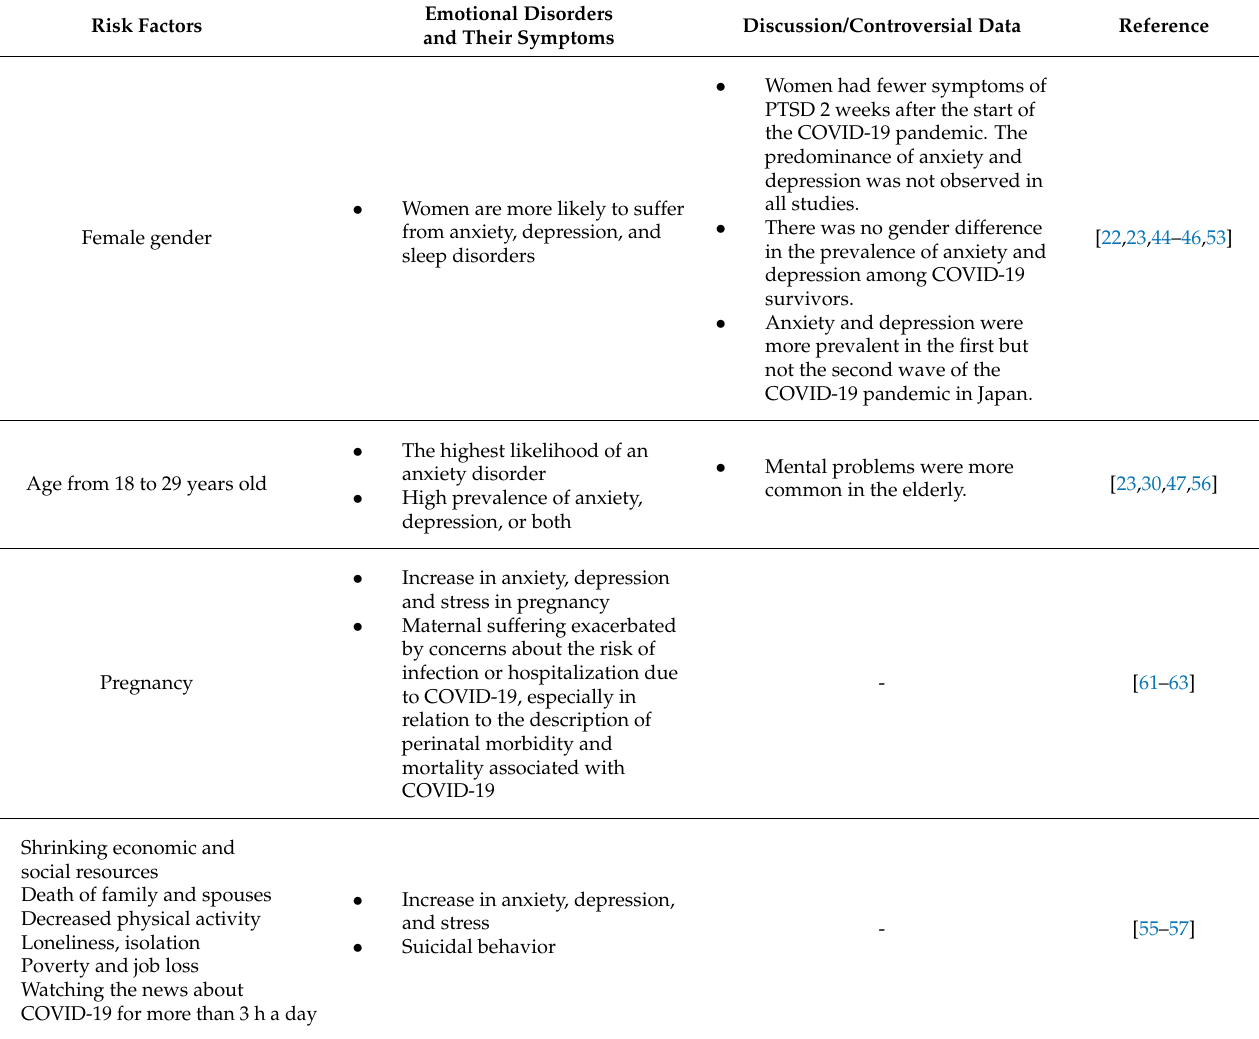
Table 1. Established general population risk factors for emotional disorders during the COVID-19 pandemic. Emotional Disorders Risk Factors and Their